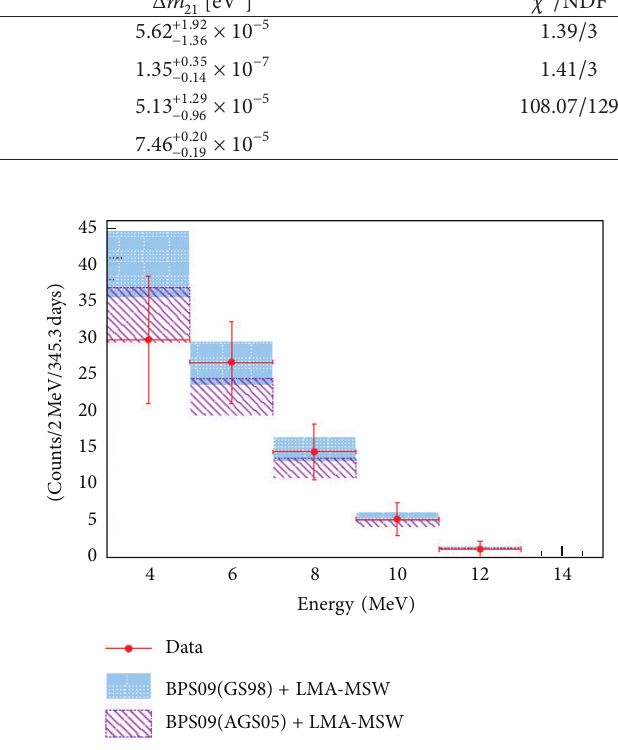
Figure 16: Projection over sin 2 𝜃 13 combining the projections obtained by analyzing data from all neutrino sources. The data from atmospheric, short-baseline experiments, and long-baseline experiments (ATM + LBL + CHOOZ) was determined from Figure 2 (left panel) in [157] which already includes the latest T2K [155] and MINOS [156] results.